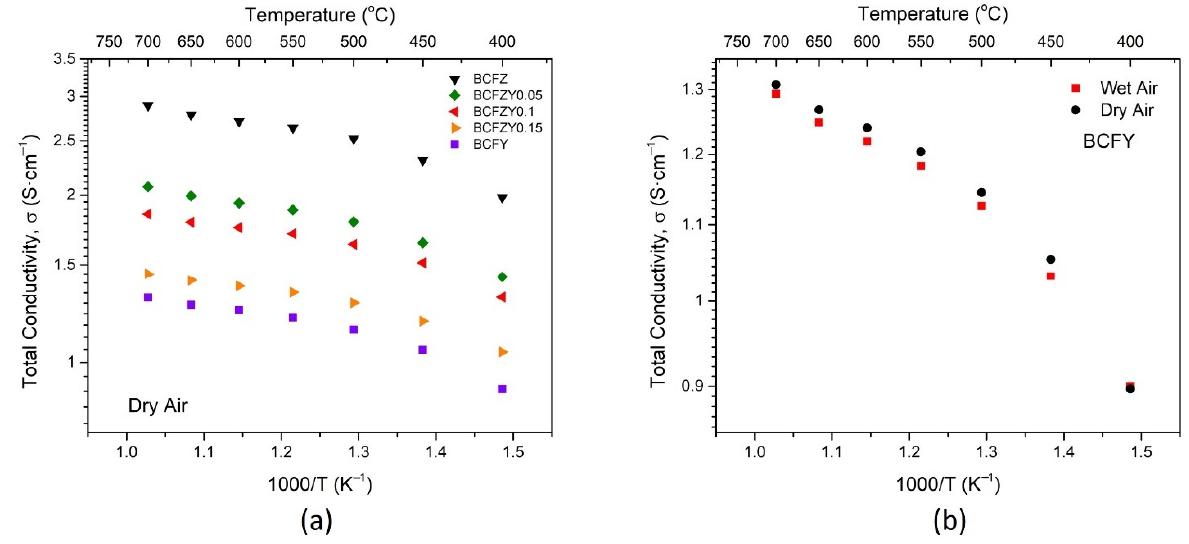
Figure 5. Total conductivity plots as a function of temperature for ( a ) BCFZY X series and ( b ) BCFY under wet and dry atmospheres.